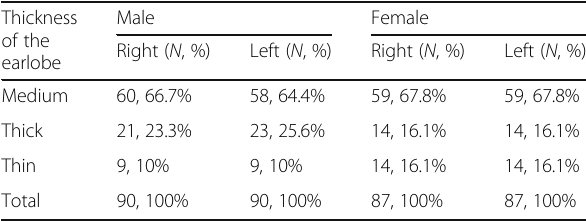
Table 5 Thickness of the earlobe in males ( N = 90) and females ( N = 87) bilaterally Thickness of the earlobe